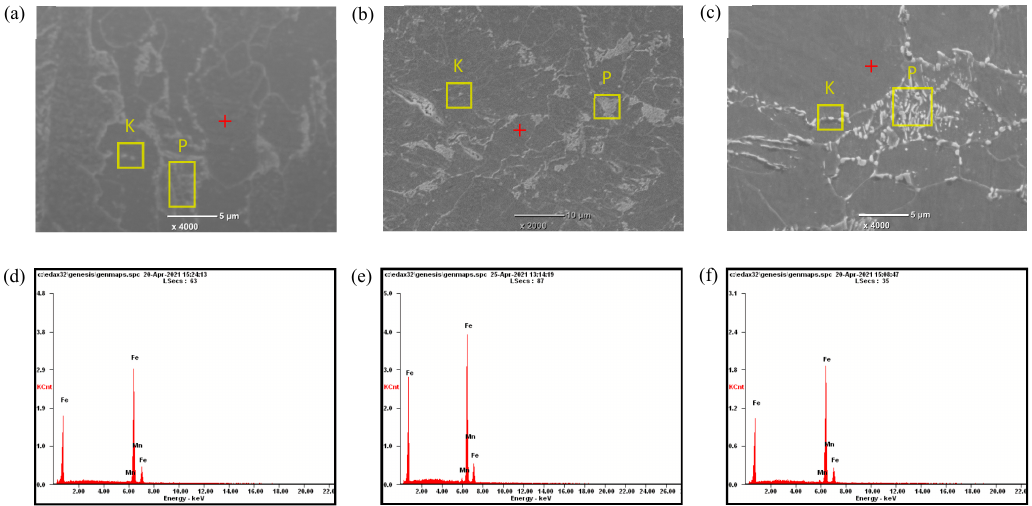
Materials 2021 , 14 , x FOR PEER REVIEW